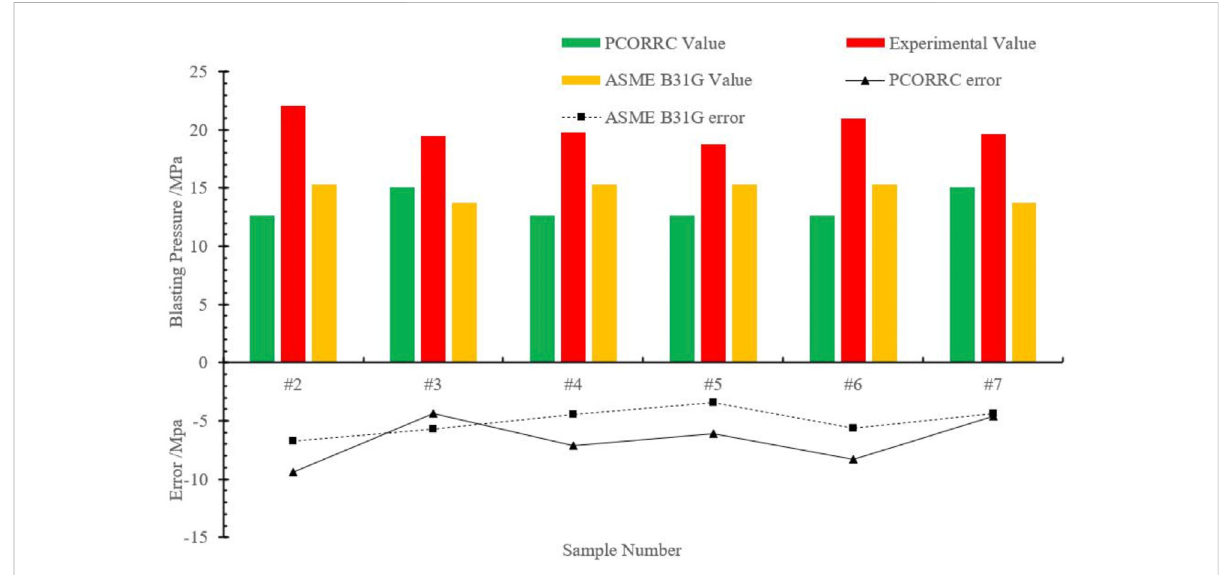
FIGURE 15 Comparisons between PCORRC and ASME B31G